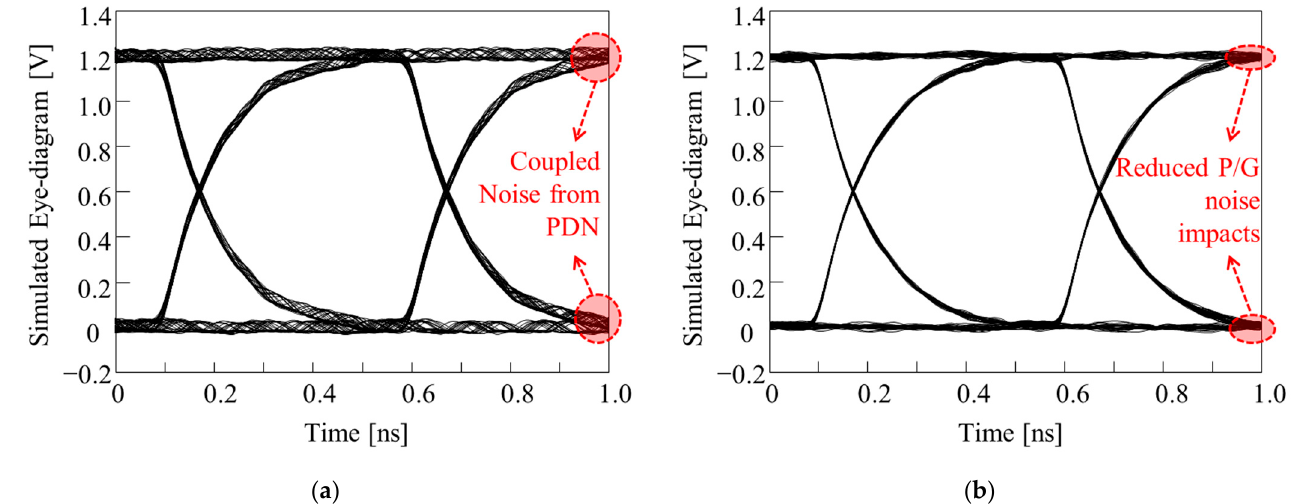
Figure 13. Verifications of the impacts of the proposed structure by eye diagram simulations. By adopting the proposed structure, power/ground noise coupling from the PDN to through-substrate via channel was suppressed. ( a ) P/G planes only. ( b ) embedded Type B structure. Table 5. Summary of the eye diagram improvement by adopting the proposed